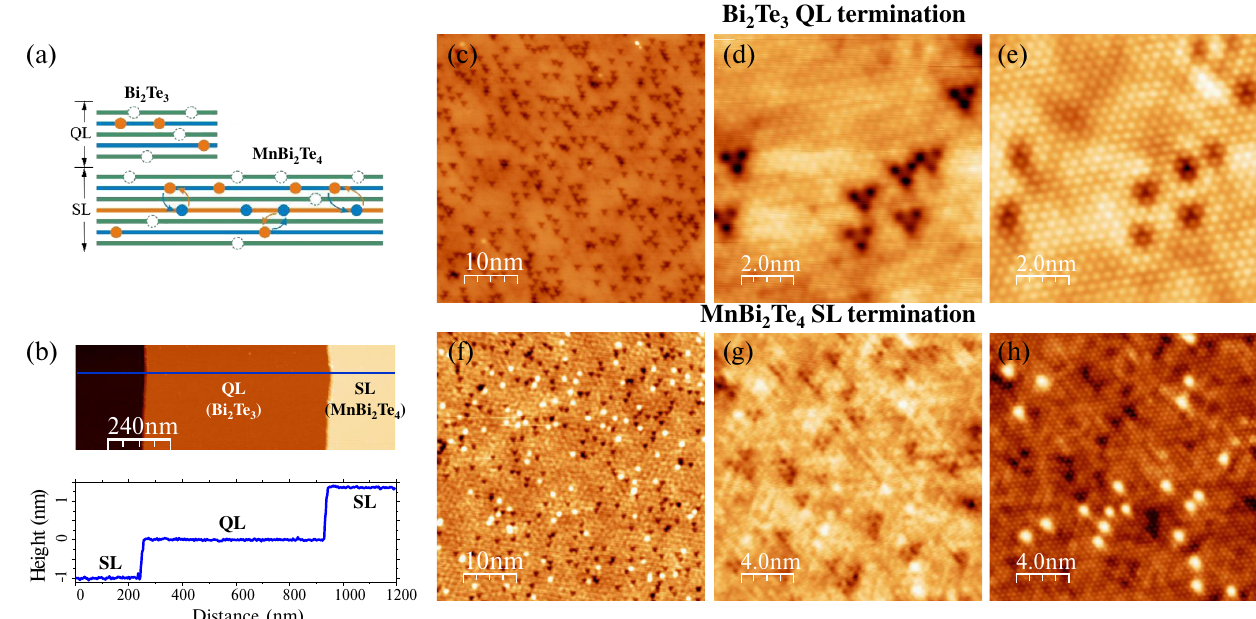
FIG. 1. STM topographic images of the MnBi 4 Te 7 surface. (a) Schematic diagram of two terminations — the QL termination of Bi 2 Te 3 and the SL termination of MnBi 2 Te 4 — with atomic defects. (b) A large area topographic image of MnBi 4 Te 7 surface showing two kinds of terrace steps. The lower part of (b) shows a line profile with step heights of 1.01 and 1.35 nm along the blue line, for the QL termination of Bi 2 Te 3 and the SL termination of MnBi 2 Te 4 , respectively. A considerable number of defects can be found in the enlarged views of the QL (c) and SL (f) terminations. (d),(e) and (g),(h) are the atomic resolution images of the same areas at different biases on the QL and SL terminations, respectively. The dark defects are found on both QL and SL terminations. For the SL, an additional type of defect is observed as a bright dot at both positive and negative biases. Tunneling parameters: (b) V